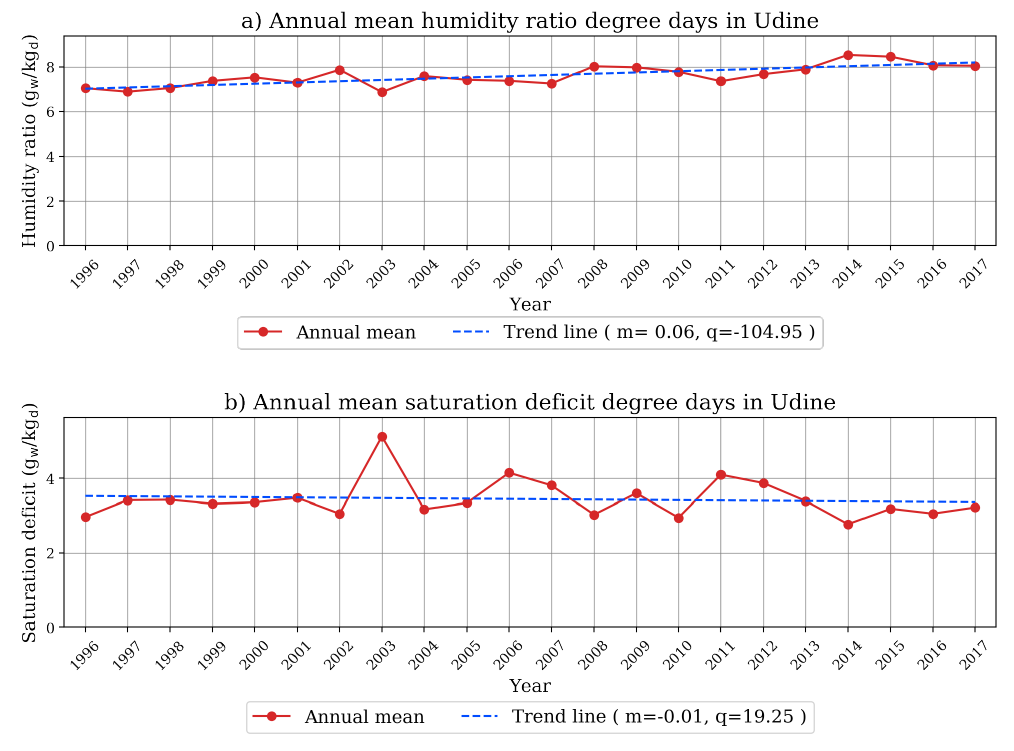
Figure 5. Annual mean humidity ratio ( a ) and annual mean saturation deficit ( b ) in Udine for each year considered in the